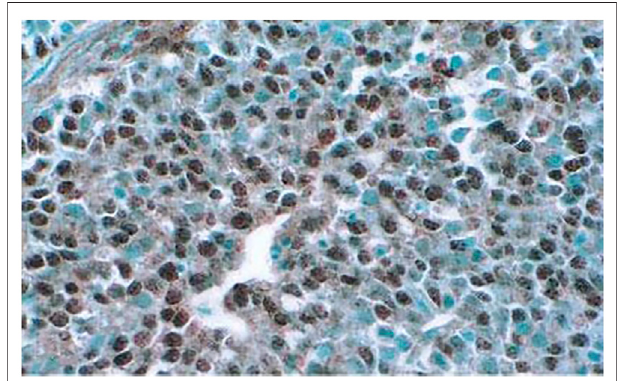
FIGURE 2 | Carcinoma of the Ovary stained for ß II. A monoclonal antibody to ß II was the primary antibody followed by a rabbit anti-mouse antibody and then Streptavidin horseradish peroxidase, followed by diaminobenzidine and OsO 2 . Brown color indicates the location of β II. Notethatmostofthecellnucleistainfor β II.Methylgreen,whichbindstoDNA, was used as the counter-stain. Note that a few nuclei do not have β II (From Yeh and Ludueña,